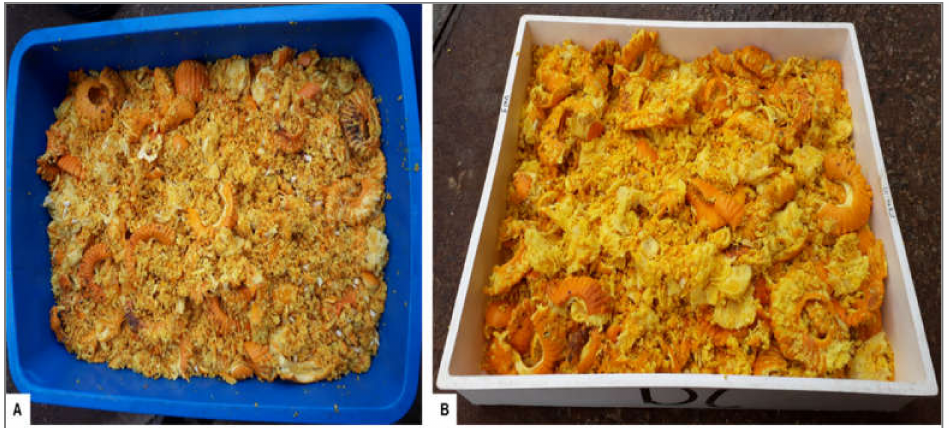
Figure 2. Citrus pulp generated from processing ‘Midknight’ Valencia oranges. ( A ) Pulp in a container and left overnight after fruit processing. ( B ) Pulp spread flat in an open tray and exposed to natural